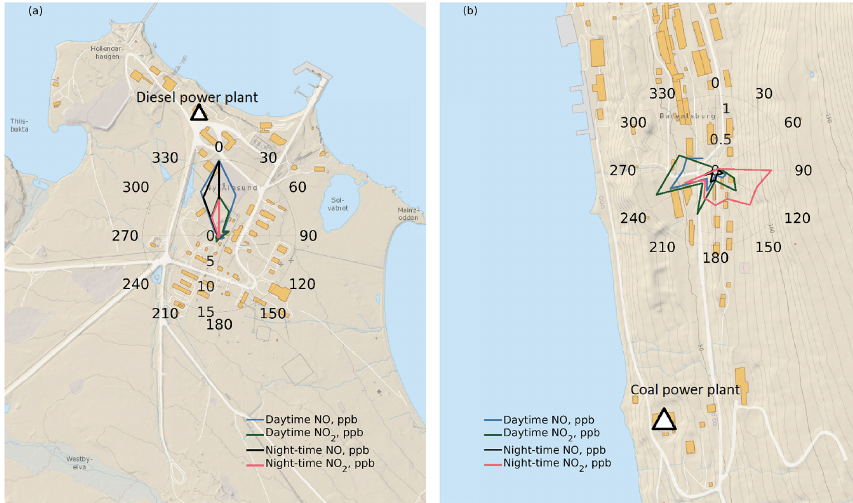
Figure 7. Distribution of average NO and NO 2 concentrations over wind directions in daytime and night-time at the stations in Ny- Ålesund (a) and Barentsburg (b) . The background maps are made using the online tool https://toposvalbard.npolar.no/, provided by the Norwegian Polar